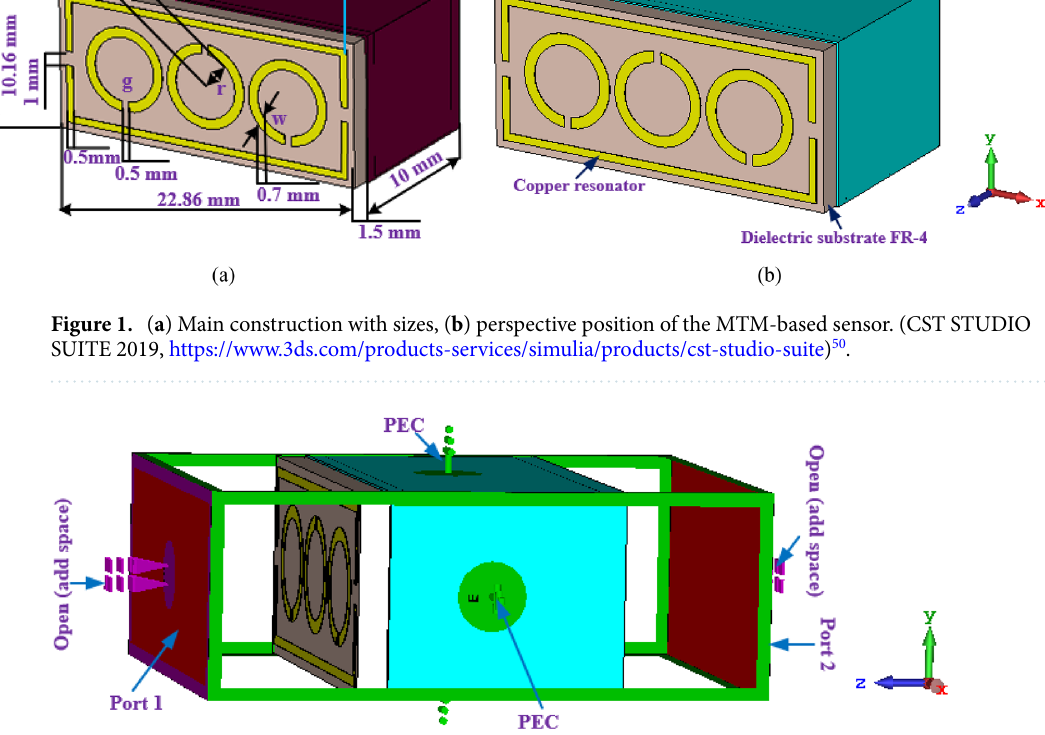
Figure 2. Design of MTM-based sensor: PEC-PEC open add spaces boundary